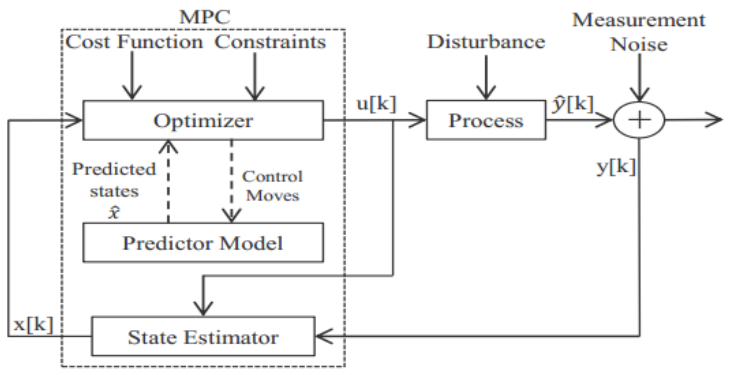
Figure 4. Basic model predictive scheme